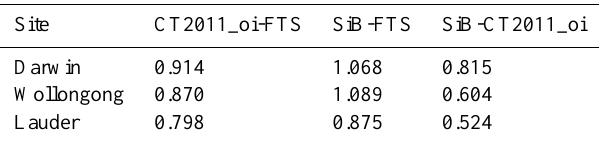
Table 4. Root mean square (rms) calculated from the fit of the SiB and CT2011_oi based simulations to the daily average measured X CO 2